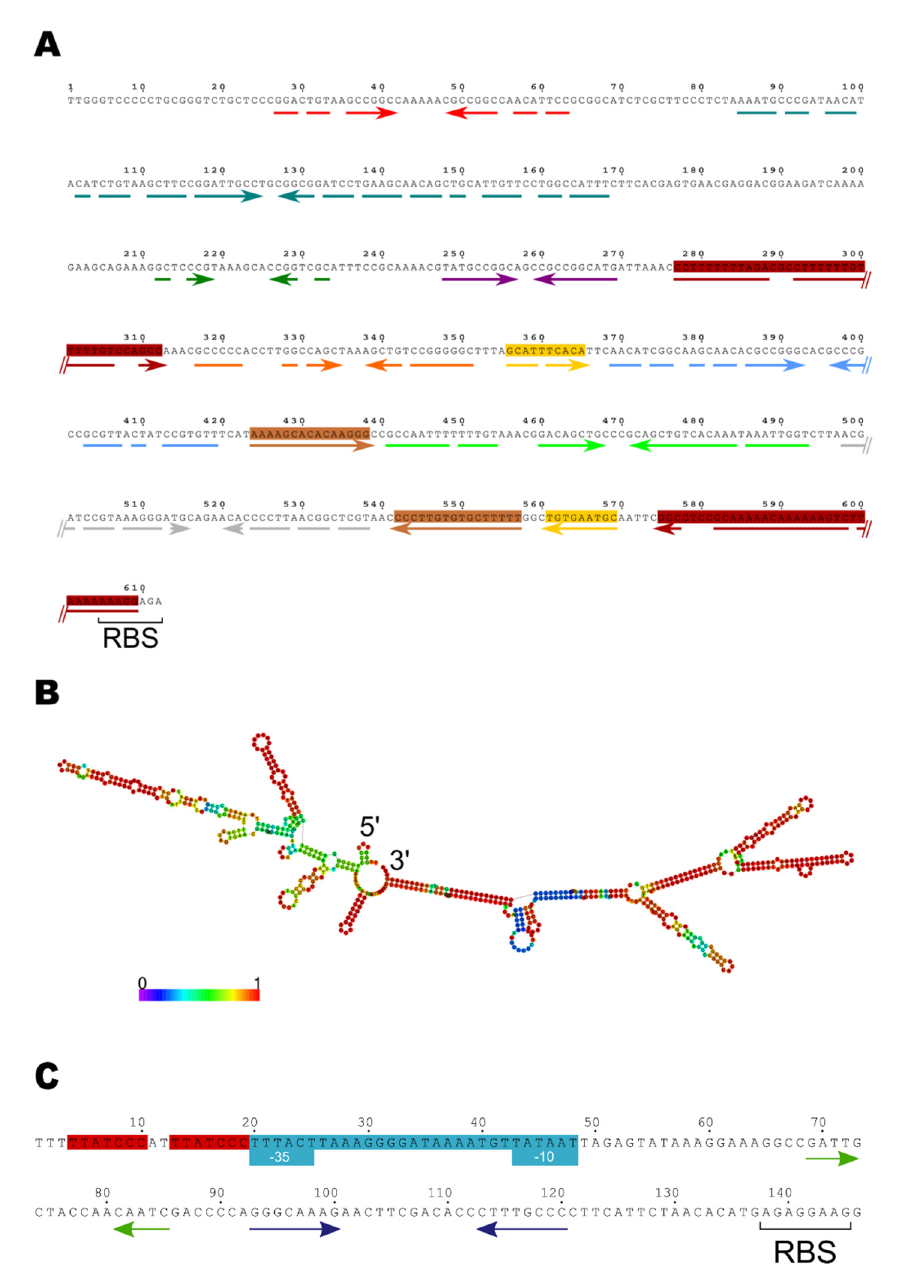
Figure 1. The region upstream of ardC pLS20 , which is different from the upstream region of ardC p576 , contains multiple inverted repeated sequences predicted to generate stable secondary structures in ssDNA or RNA. ( A ) The 600 bp region immediately upstream of the ribosome binding site (RBS) of ardC pLS20 contains multiple inverted repeated sequences. Inverted repeated sequences are indicated with coloured arrows shown above the sequence. The inverted repeated sequences that are separated by sequences of more than 100 bp, which themselves can contain other inverted repeated sequences, are boxed. ( B ) Centroid secondary structure predicted to be formed according to the RNAfold web server (rna.tbi.univie.ac.at//cgibin/RNAWebSuite/RNAfold.cgi) when the upstream region is in its single-stranded form. A very similar secondary structure is predicted when the region is transcribed into RNA. The sequence immediately upstream of the RBS is predicted to form a branch of ~300 nt with four ramifications (positioned at the right side of the image). Upstream of this branch, another branch of ~300 nt would be formed, with two and three ramifications predicted to be formed with low and high probability, respectively. Colours indicate the degree of probability that the predicted secondary structure is formed. Red nucleotides reflect very high probabilities. Levels of decreasing probabilities are indicated by nucleotides in orange, yellow, green, light blue,